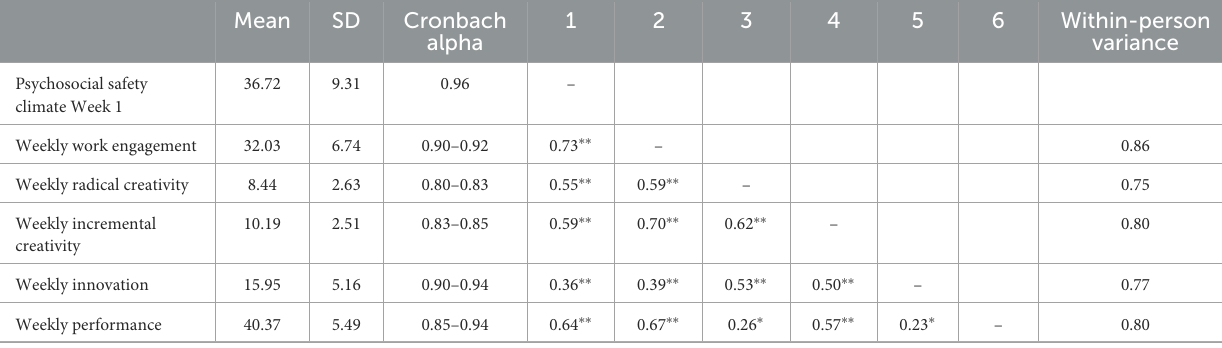
TABLE 1 Means, standard deviations, reliability, bivariate correlations, and within-person